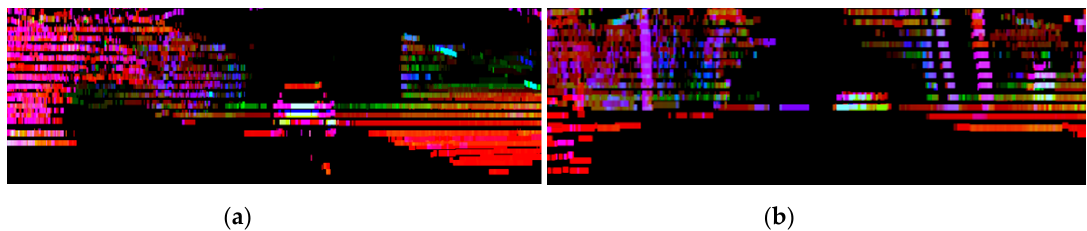
Figure 3. Changes in the frustum image according to the distance of the target vehicle: ( a ) close and ( b ) far. ( b )